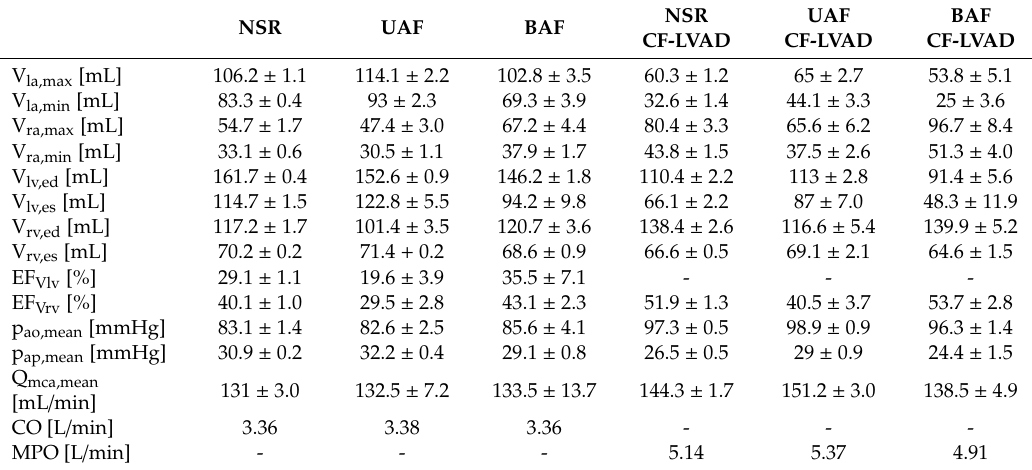
Table 1. The mean values and standard deviations of maximal and minimal volumes in the heart chambers (V la,max , V la,min , V ra,max , V ra,min , V lv,ed , V lv,es , V rv,ed , V rv,es ), left and right ventricular